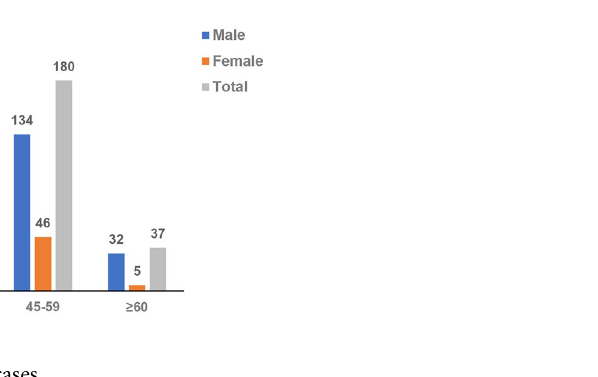
Figure 1. Age distribution of all 649